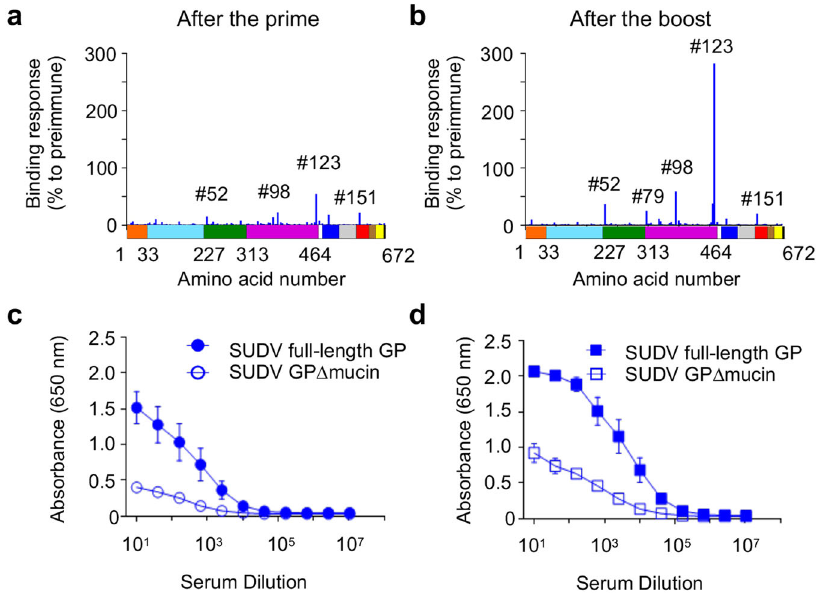
Fig. 4 Amino acids 489-499 in GP1, by the furin cleavage site, are the main epitope targeted by MVA-VLP-SUDV. Sera collected after the fi rst a and the second b vaccine doses were analyzed for binding to peptides matching the protein sequence of SUDV Gulu GP. Mean value of serum binding from three responders to each overlapping peptide is displayed as a percentage of the binding of pre-immune sera. The diagram below each graph shows the domains of GP in a linear fashion that correspond to the binding data: signal sequence (orange), receptor-binding domain (light blue), glycan cap (dark green), mucin-like domain (magenta), furin cleavage site (white), internal fusion loop (dark blue), heptad repeat 1 (light green), heptad repeat 2 (red), membrane proximal external region (brown), transmembrane domain (yellow) and cytoplasmic tail (black). Amino acid numbers for the N-terminus of the selected domains are indicated according ref. 15 . Sera collected after the fi rst vaccine dose (day 27) c and the second vaccine dose (day 54) d were tested by ELISA for binding to SUDV full-length GP and GP Δ mucin. Mean values ± SEM.